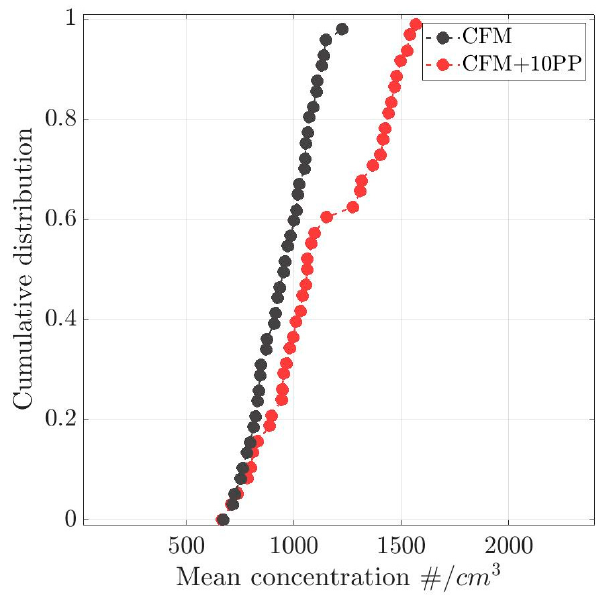
Figure 11. Cumulative distribution of mean emission concentrations of CFM and CFM with 10 PP in the specific section.